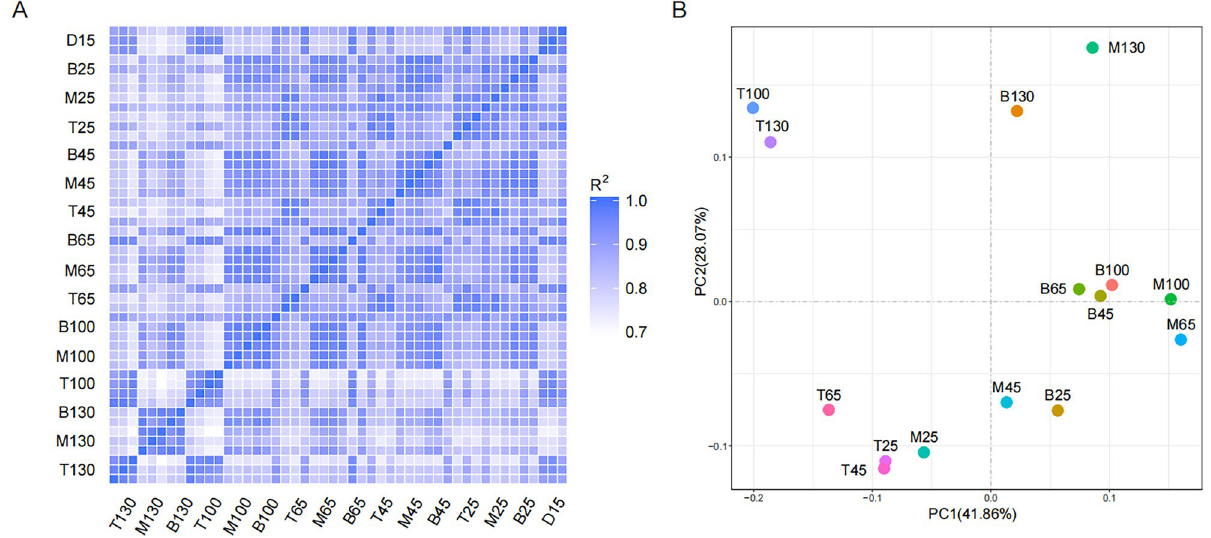
Figure 1. The correlation ( A ) and principal component analysis ( B ) for the antler samples. The figures weres generated using the R software (vesion 4.1.3, https:// www.r- proje ct.